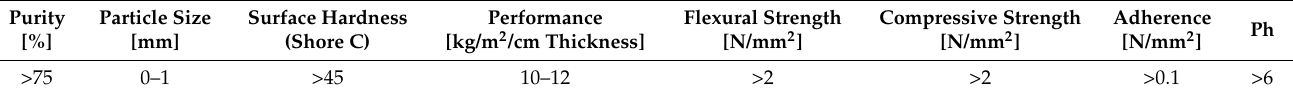
Table 2. Characteristics of gypsum powder used as base material.